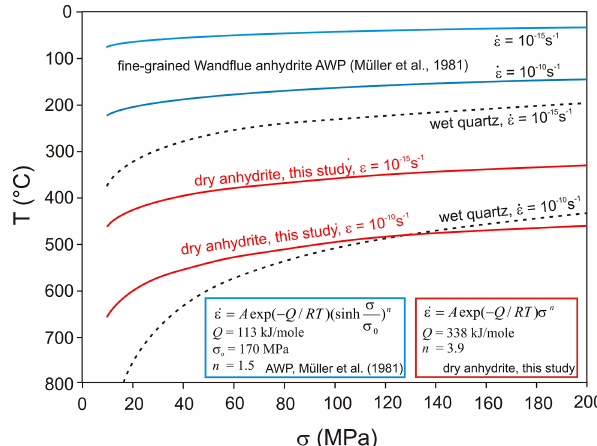
Figure 14. Flow stress of dry anhydrite as a function of temper- ature calculated for slow geological strain rates of 10 − 10 s − 1 and 10 − 15 s − 1 compared to predictions based on the experimental flow law for fine-grained Wandflue anhydrite AWP derived by Müller et al. (1981). Flow law parameters are given in the figure. A flow law for wet synthetic quartzite (Paterson and Luan, 1990) is included for